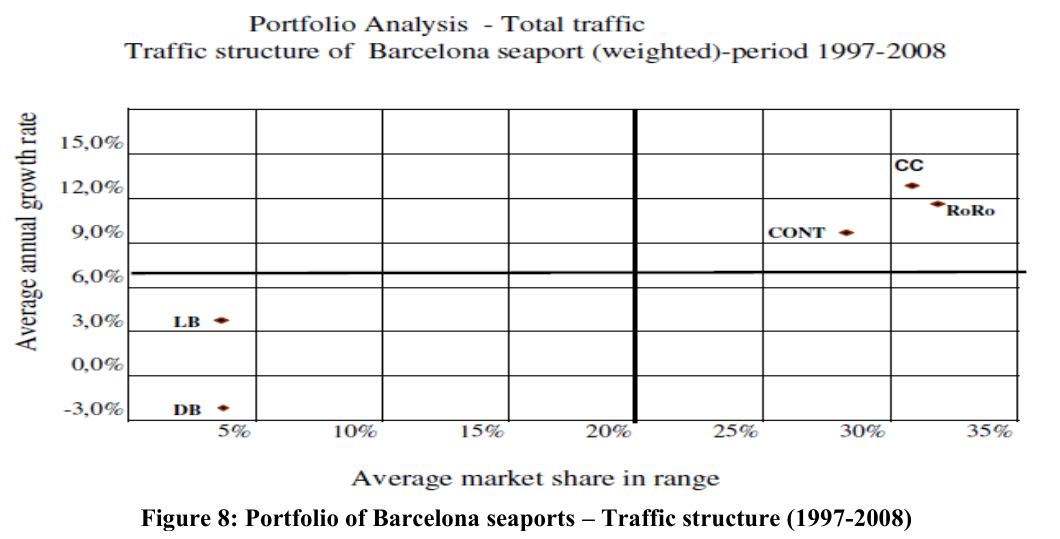
Figure 8: Portfolio of Barcelona seaports – Traffic structure (1997-2008)